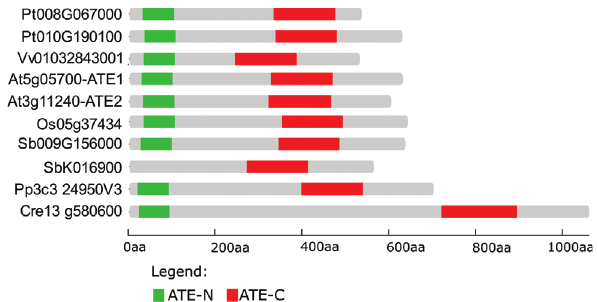
Figure 2 - Domain location of ATE protein sequences among plant spe- cies. ATE coding sequences from distinct plant species, such as the eudicots Populus trichocarpa , Arabidopsis thaliana and Vitis vinifera , monocots Sorghum bicolor and Oryza sativa , moss Physcomitrella patens and green alga Chlamydomonas reinhardtii, were extracted from Phyto- zome V11.0. The full-length protein schemes were generated by Gene Structure Display Server 2.0 software; shown are the ATE domains identi- fied by Pfam